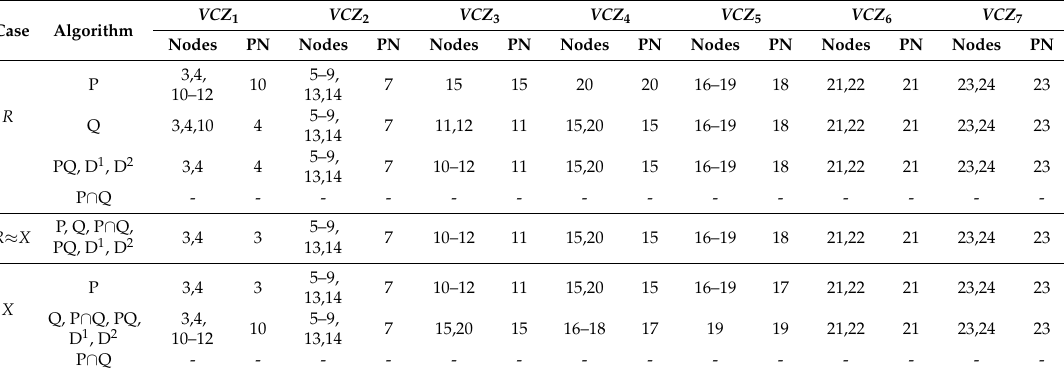
Table 7. Nodes and pilot nodes for seven